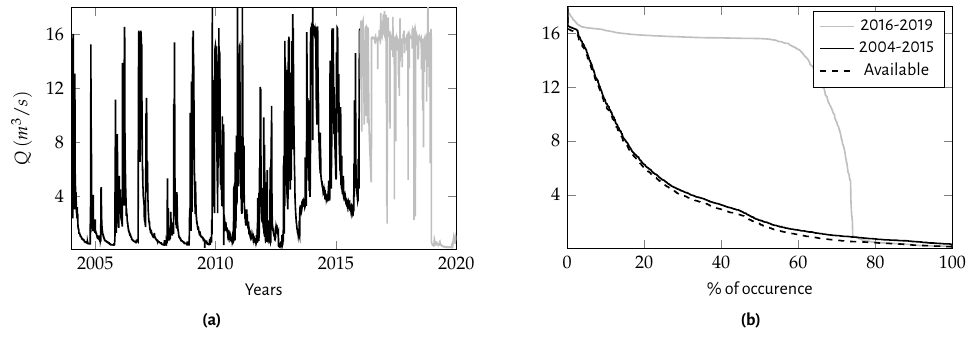
Figure4. (a)Flow-ratedataseriesand(b)durationflow-ratecurves. Figure 4. ( a ) Flow-rate data series and ( b ) duration flow-rate